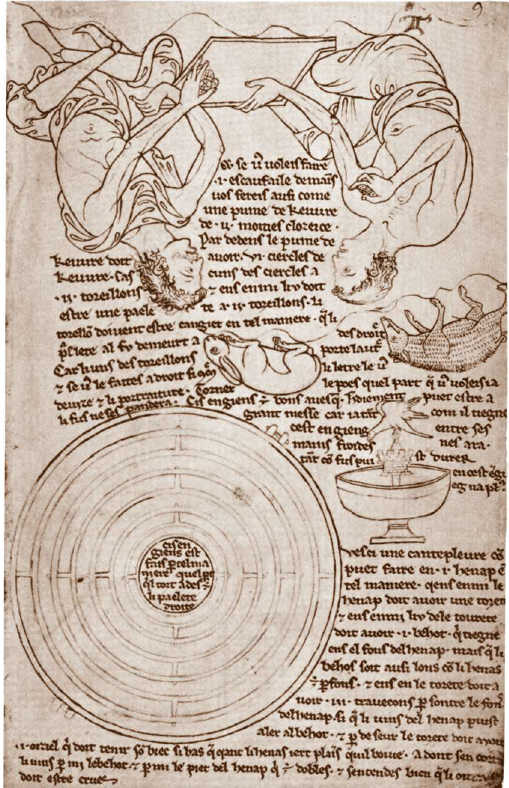
Figure 3. The Cardan suspension in the notebook of Villard de Honnecourt, c. 1237.